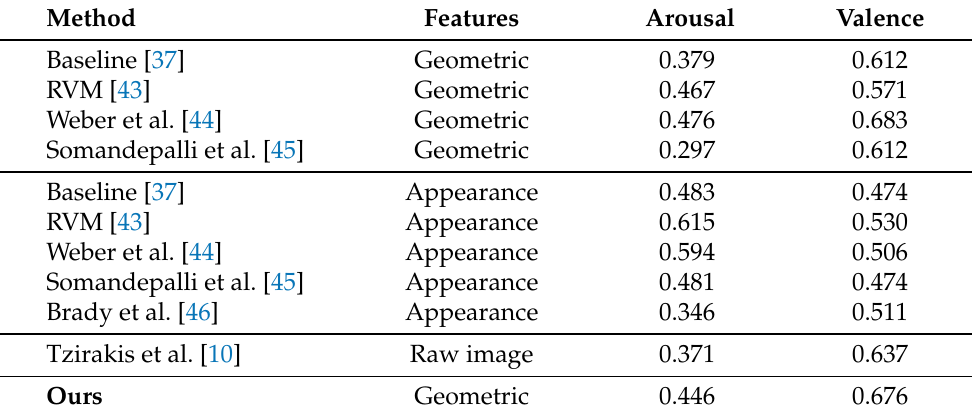
Table 5. RECOLA results in terms of CCC for prediction of arousal and valence